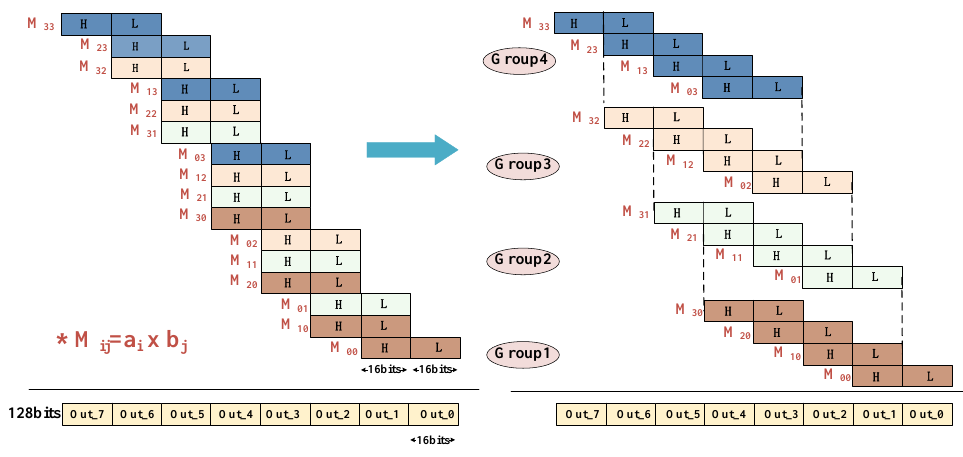
Figure 3. The PPA process of MUL16.